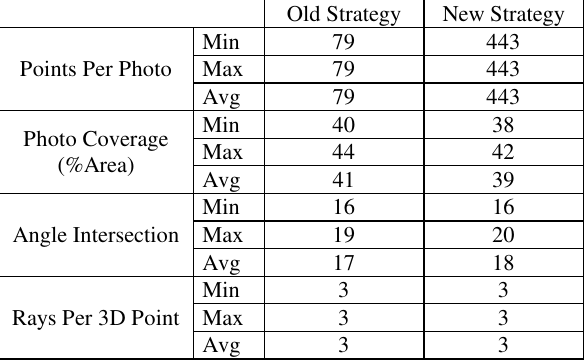
Figure 2. The Marbrees sequence. Left : the image block geometry. Right : the DSM of the rock-mass.